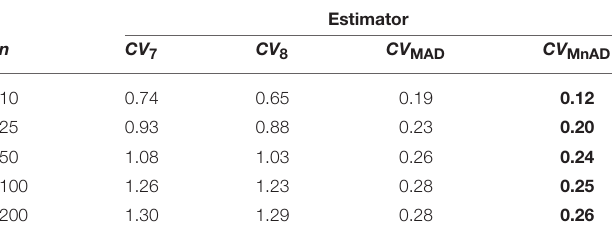
TABLE 9 | Median values of log 10 ( γ ) accuracy metric across θ produced for each estimator and sample sizes under the Lognormal distribution.